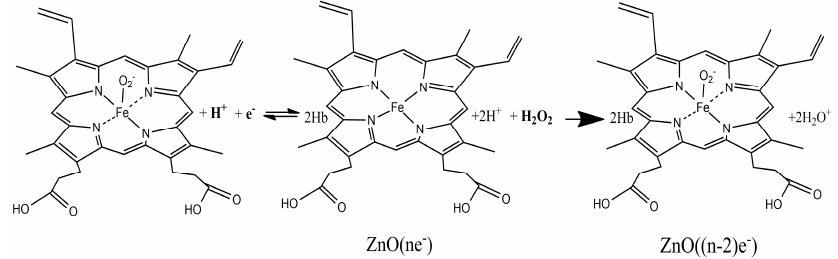
Figure 8. Reaction scheme for the direct reduction and oxidation of the immobilized hemes of Hb and the electrocatalytic reduction of H 2 O 2 on the sensor (created on Chemdraw).